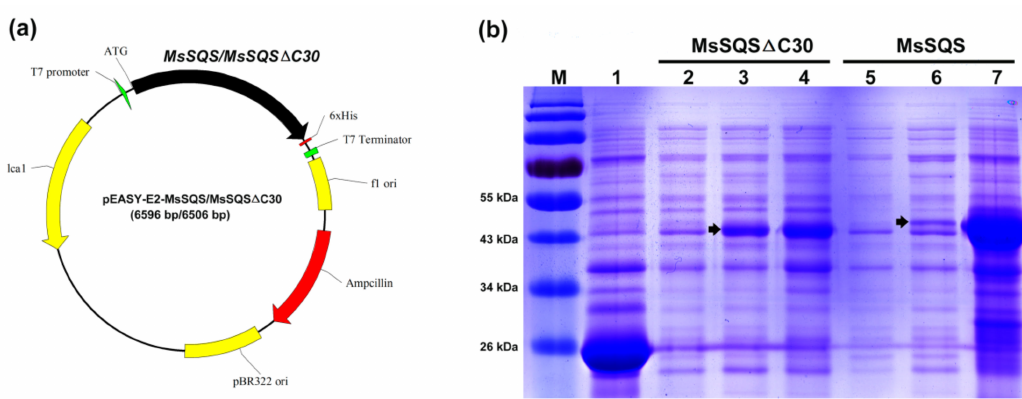
Figure 5. Vector construct and expression analysis of MsSQS / MsSQS ∆ C30 by SDS-PAGE. ( a ) Construct of pEASY-E2-MsSQS or pEASY-E2- MsSQS ∆ C30; ( b ) SDS-PAGE analysis of MsSQS and MsSQS ∆ C30 expressed in E. coli. M: protein ladder, Lane 1: total proteins from IPTG-induced cells expressing pEASY-E2 (Control), Lane 2–Lane 4: proteins from cells expressing pEASY-E2-MsSQS ∆ C30, for total proteins without IPTG treatment (Lane 2), proteins from the supernatant (Lane 3) or from the total cells (Lane 4) treated by IPTG; Lane 5–Lane 7: proteins from cells expressing pEASY-E2-MsSQS, for total proteins without IPTG treatment (Lane 5), proteins from the supernatant (Lane 6) or from the total